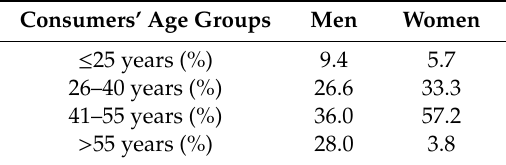
Table 3. Consumer profile for visual appraisal and purchase intention tests.